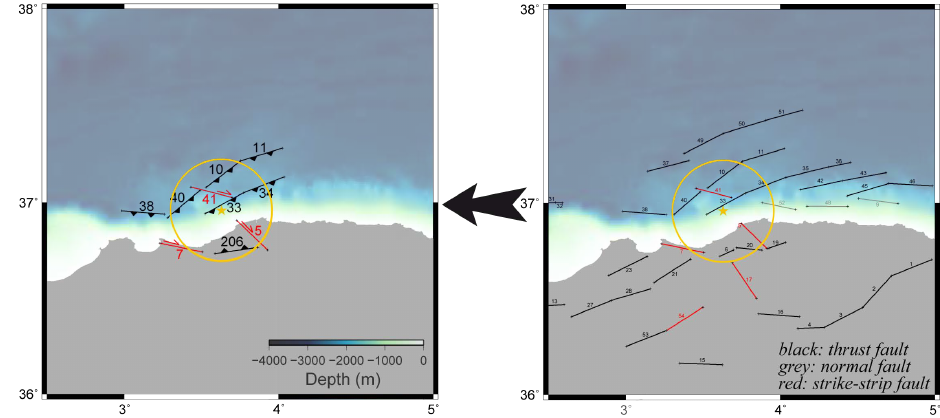
Fig. 4. Detailed view on the 2003 Boumerdès earthquake and precomputed unit source functions available in the area: (yellow star) epicenter of the event; (yellow circle) inaccuracy search